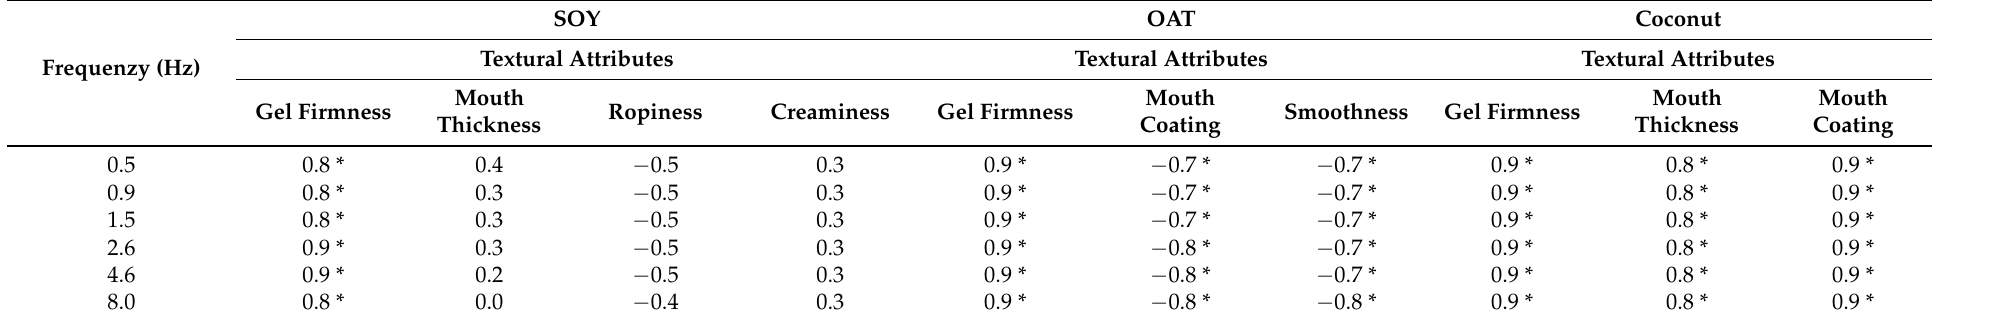
Table 7. Correlation coefficients between G* and textural attributes identified in each fermented base. SOY OAT Coconut Textural Attributes Textural Attributes Textural Frequenzy (Hz)